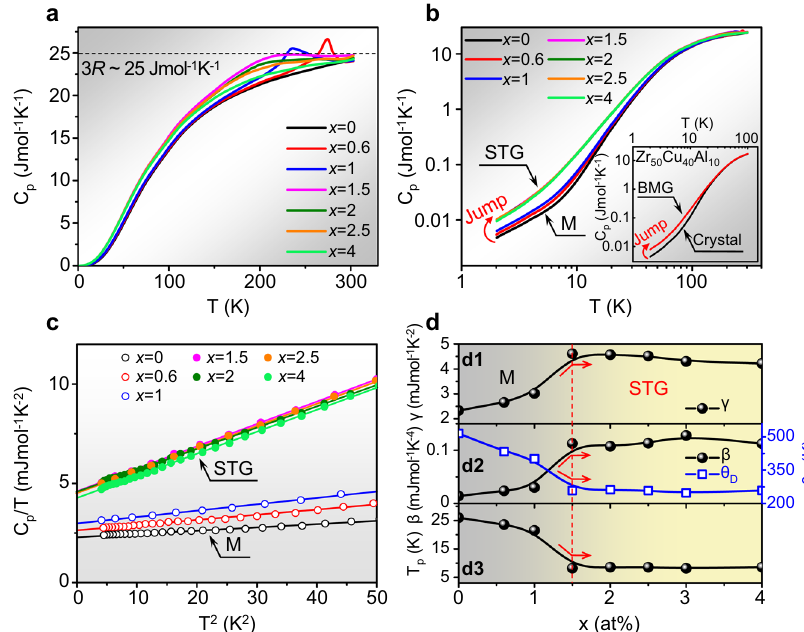
Fig. 1 Speci fi c heat ( C p ) and thermal parameters in strain glass alloys. a The C p curve for each x in Ti 50 − x Ni 50 + x . The dashed line represents the classical value of Dulong-Petit law. b C p as a function of temperature in the logarithmic scale. A jump in C p can be observed from the martensite (M) to strain glass (STG) at low temperatures. The inset exhibits a similar jump between Zr 50 Cu 40 Al 10 bulk metallic glass (BMG) and its corresponding crystal. c C p / T vs. T 2 relation for each x with the C p data below 7 K. The linear fi tting follows the formula of C p / T = γ + β T 2 . d The composition dependence of thermal parameters, including ( d1 ) the electronic speci fi c heat coef fi cient γ , ( d2 ) the calorimetric cubic coef fi cient β and the Debye temperature Θ D , and ( d3 ) the peak temperature ( T p ) in the plot of reduced speci fi c heat ( C p – γ T )/ T 3 vs. T in Fig. 2. The dashed line and the red arrows illustrate the crossover between the martensite and strain glass.